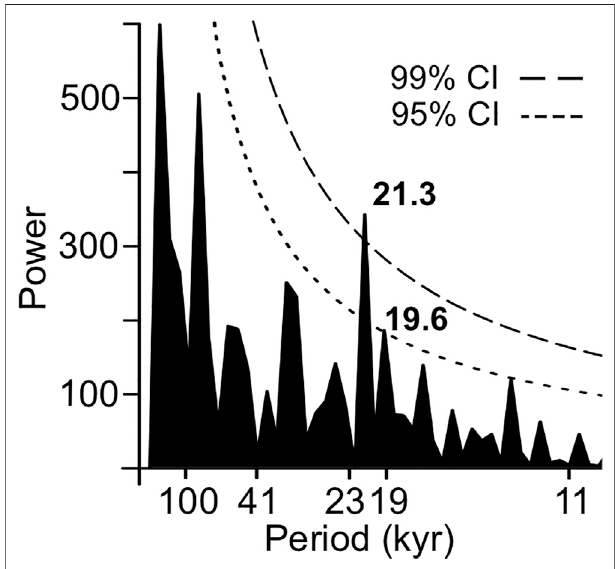
FIGURE 4 | Spectral analysis of microcharcoal concentrations. Periodicities > 5 × the 3,100-yr time step with power above the 95 and 99% con fi dence levels are labeled on the